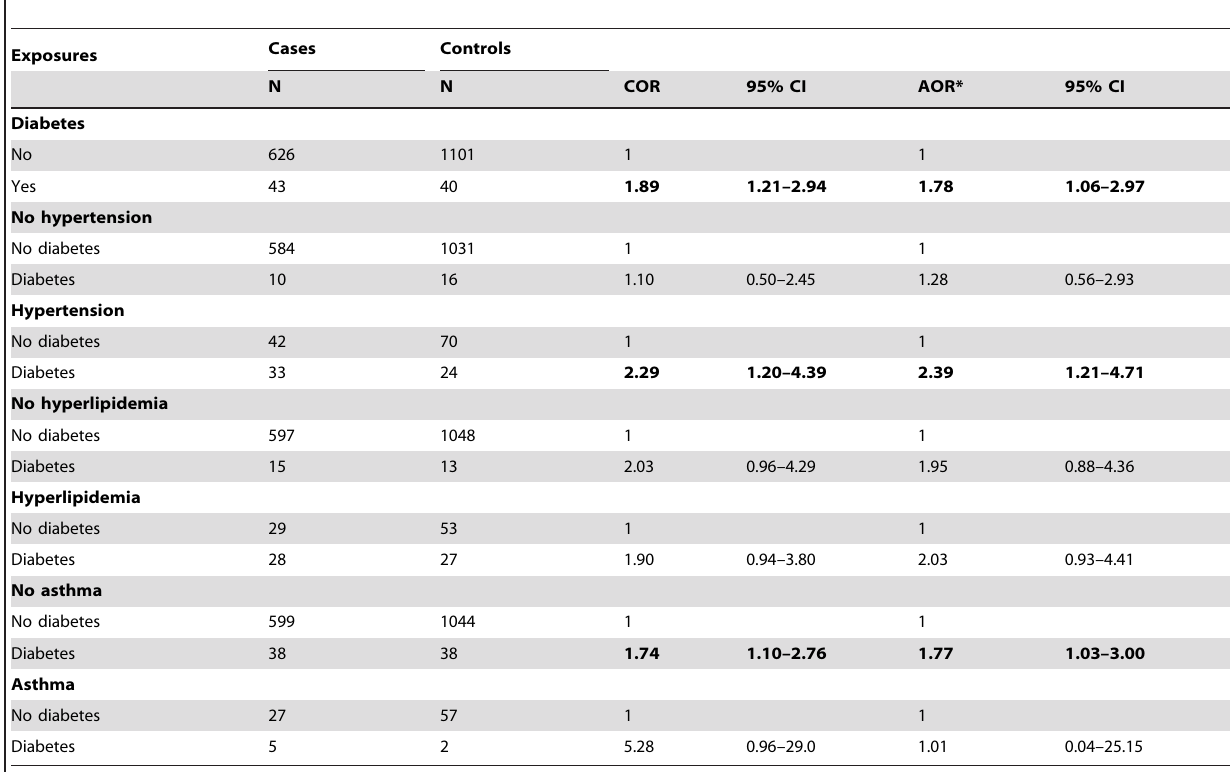
Table 5. Interaction effect between diabetes mellitus and other comorbidities in year 2007–2008 epidemic.